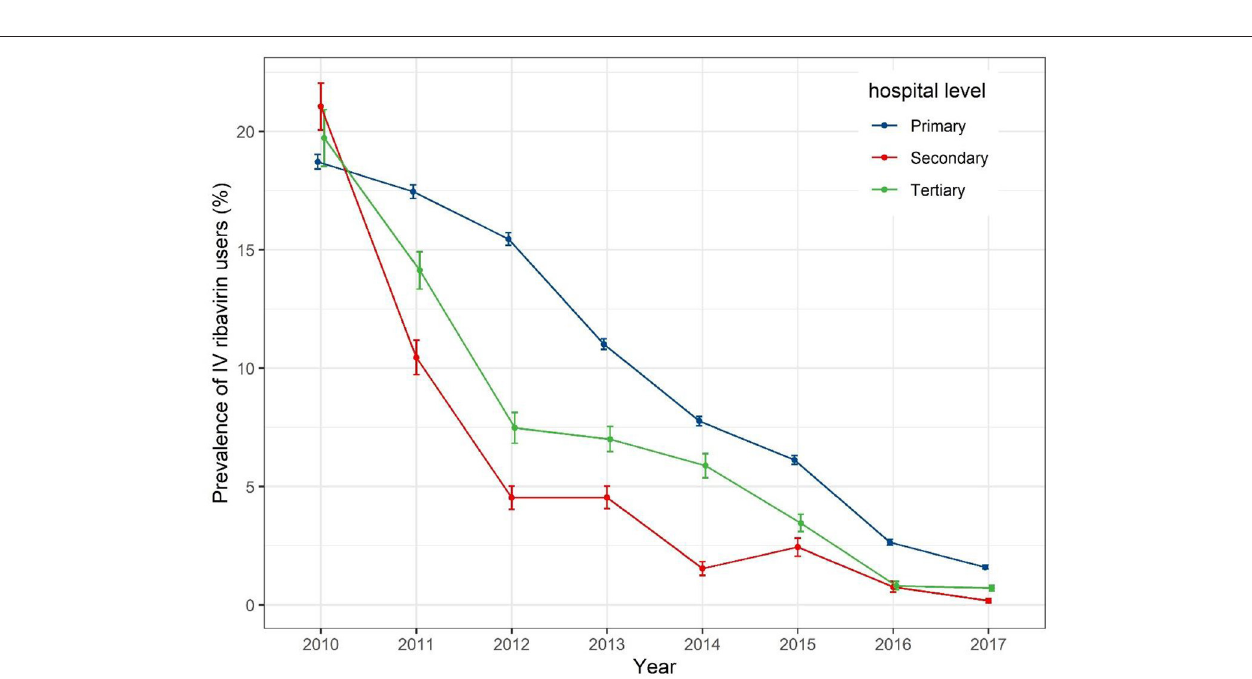
FIGURE 3 | Prevalence of use of IV ribavirin from 2010 to 2017 stratified by hospital level.